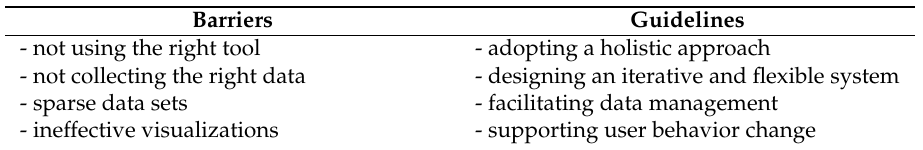
Table 2. System Design Barriers and Guidelines. This table summarizes the identified barriers and resulting guidelines to design an effective self-quantification